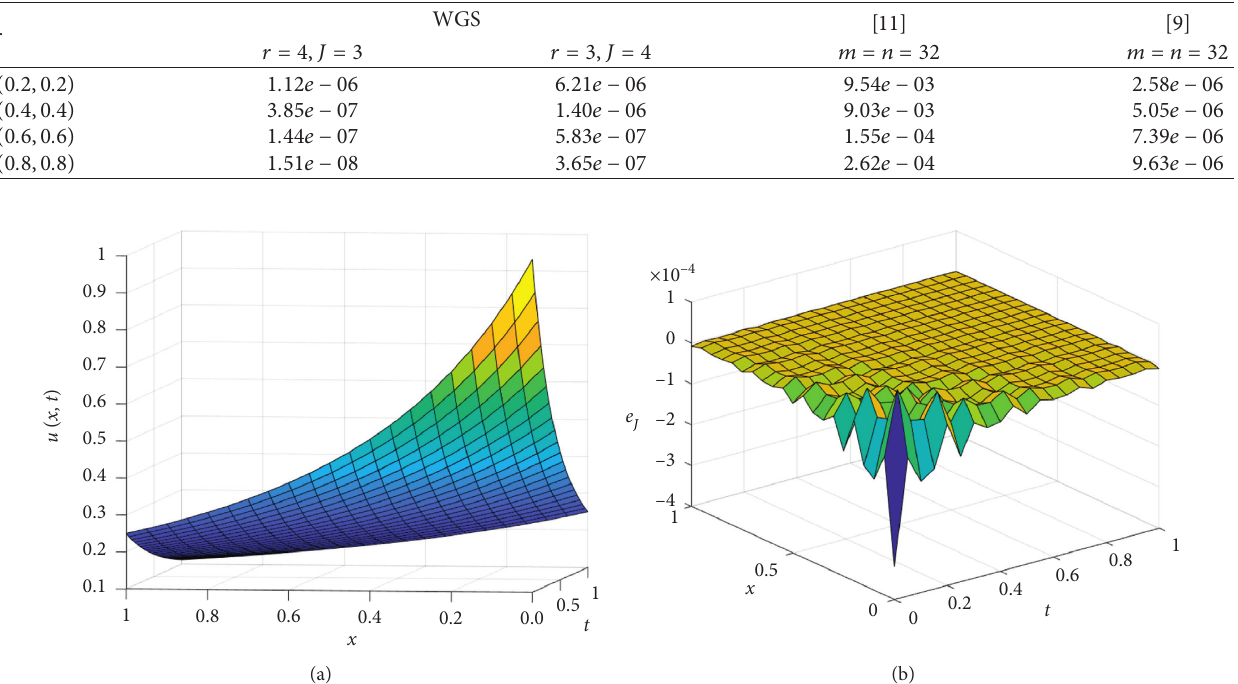
Figure 1: The surfaces of the approximate solution and the absolute error taking r � 4 and J � 2 for Example 1.